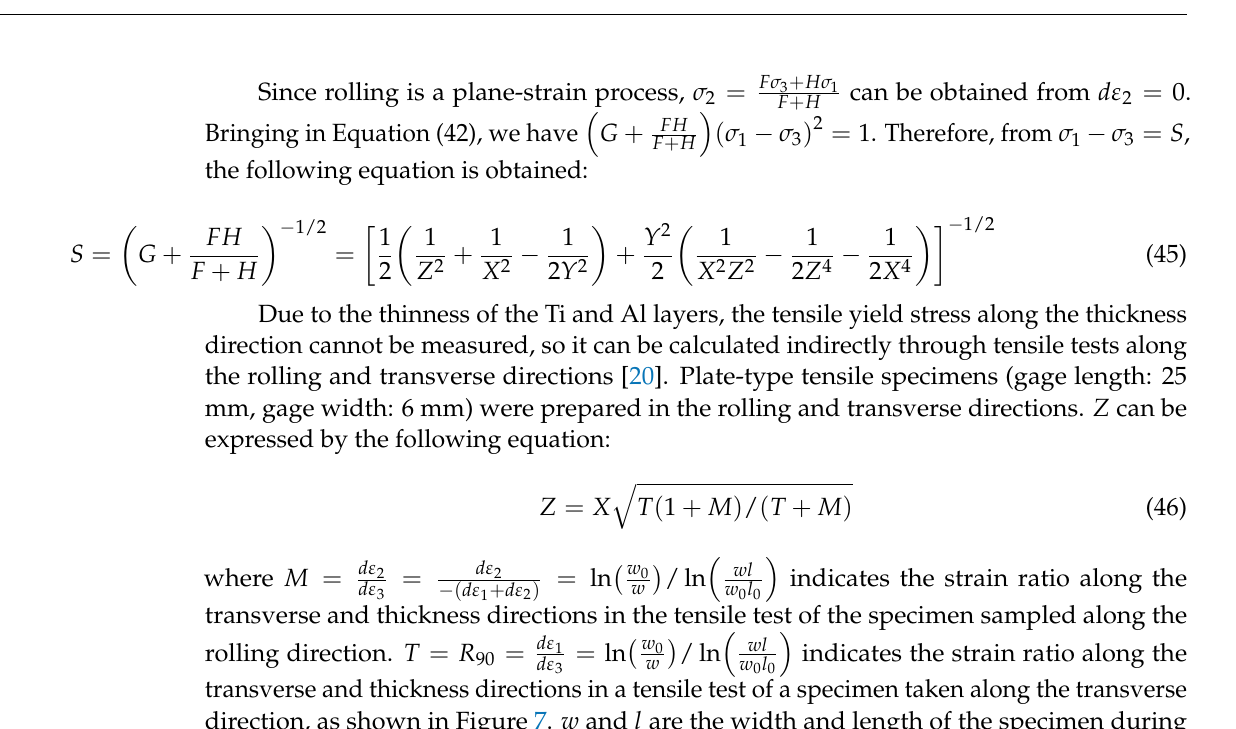
transverse and thickness directions in a tensile test of a specimen taken along the trans- during the tension test, and directions.